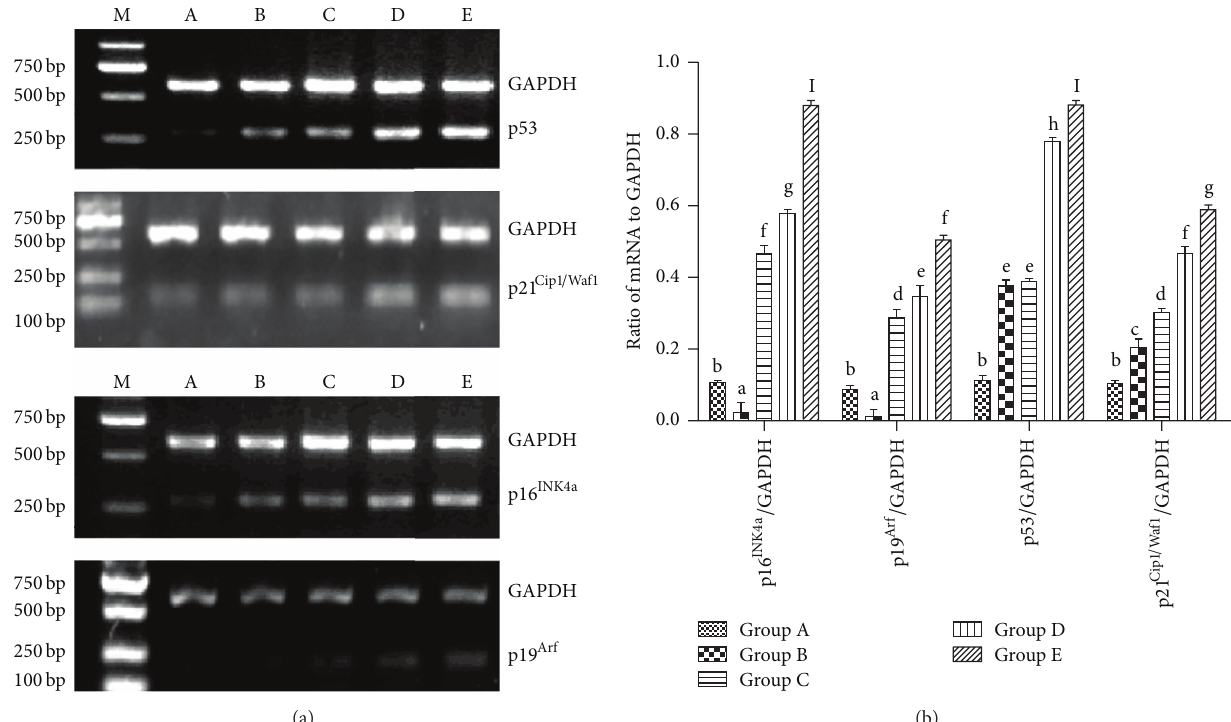
Figure 6: The mRNA expression of p16 INK4a , p19 Arf , p53, and p21 Cip1 / Waf1 in Sca-1 + HSPCs. (a) Result of RT-PCR. M: DNA mark, A: Group A (3-4-week-old mice, 13–16 g in body weight), B: Group B (8-9-week-old mice, 20–25 g in body weight), C: Group C (6-month-old mice, 35–40 g in body weight), D: Group D (12-month-old mice, 39–43 g in body weight), and E: Group E (18-month-old mice, 37–45 g in body